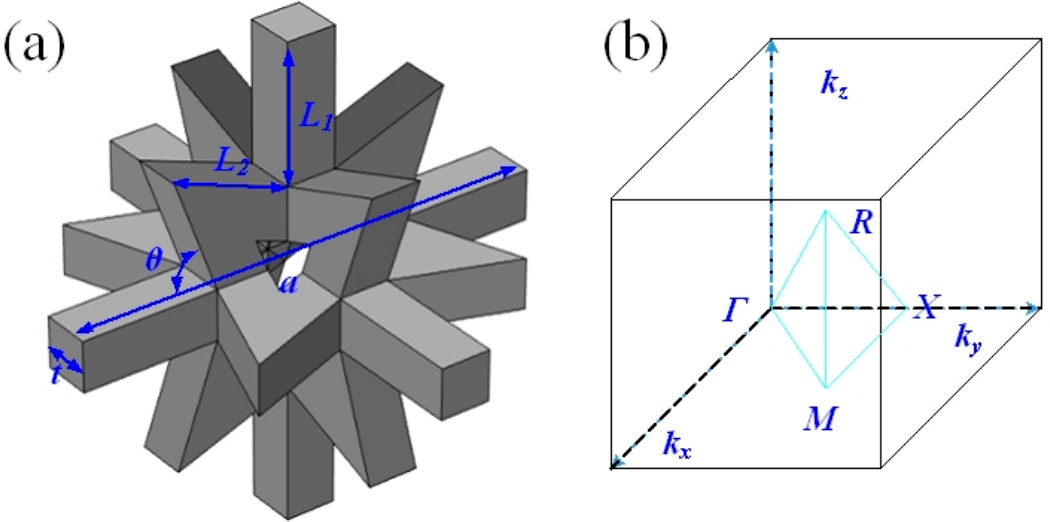
Figure 1. Schematic of the 3D Star structure ( a ) and the Brillouin zone of simple cubic lattice ( b ).